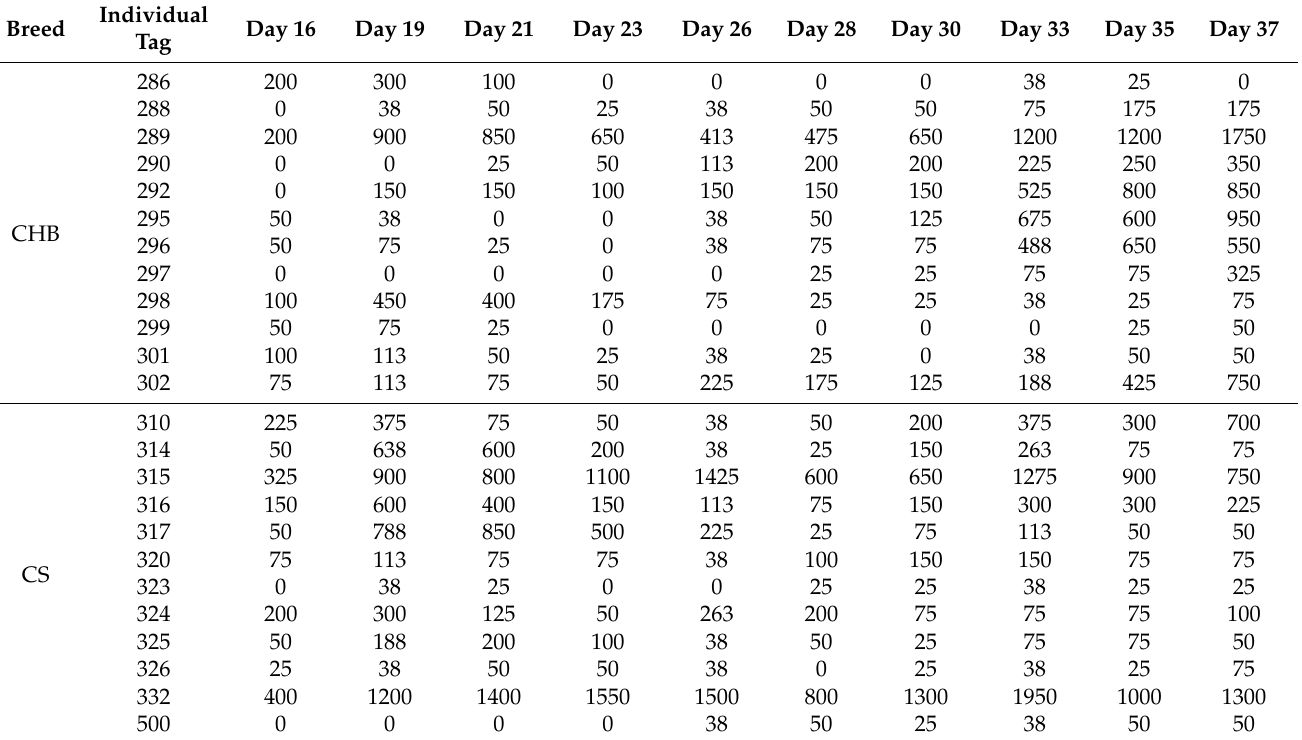
Figure 2. Individual cumulative faecal egg counts in three ‐ month ‐ old sheep after trickle infection with Teladorsagia circumcincta infective larvae ( n = 24).